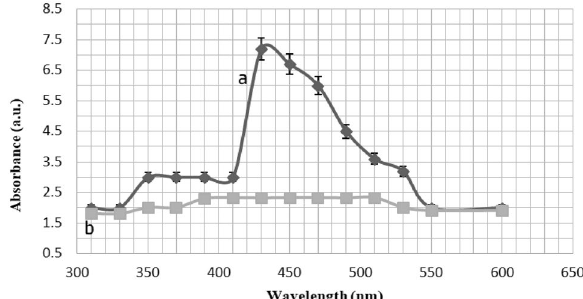
Figure 3. UV–visible rang spectra of ( a ) Ag NPs synthesized from C. sinusa extract and ( b ) C. sinusa extract.